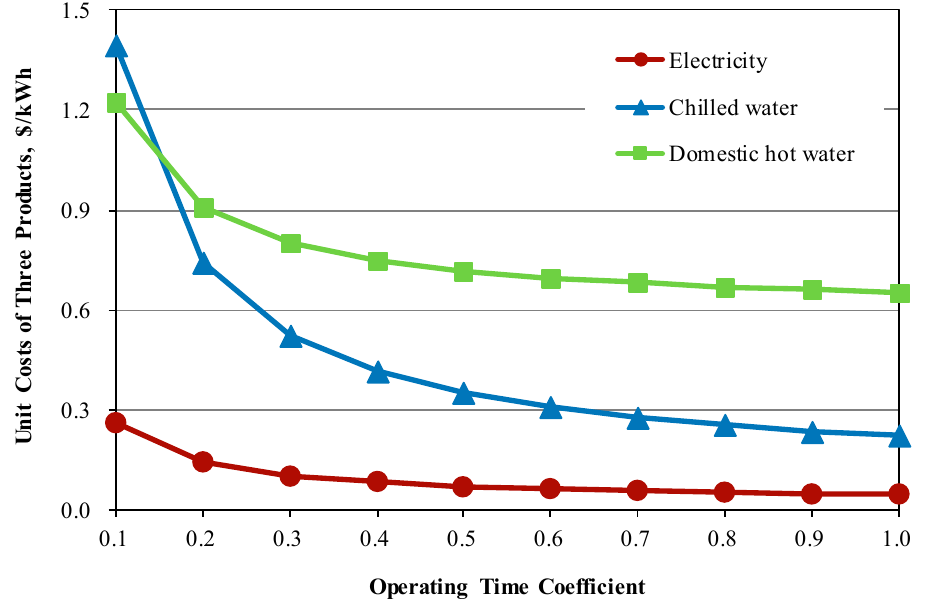
Figure 10. Variations of unit exergy cost of products with operating time coefficient in cooling mode.